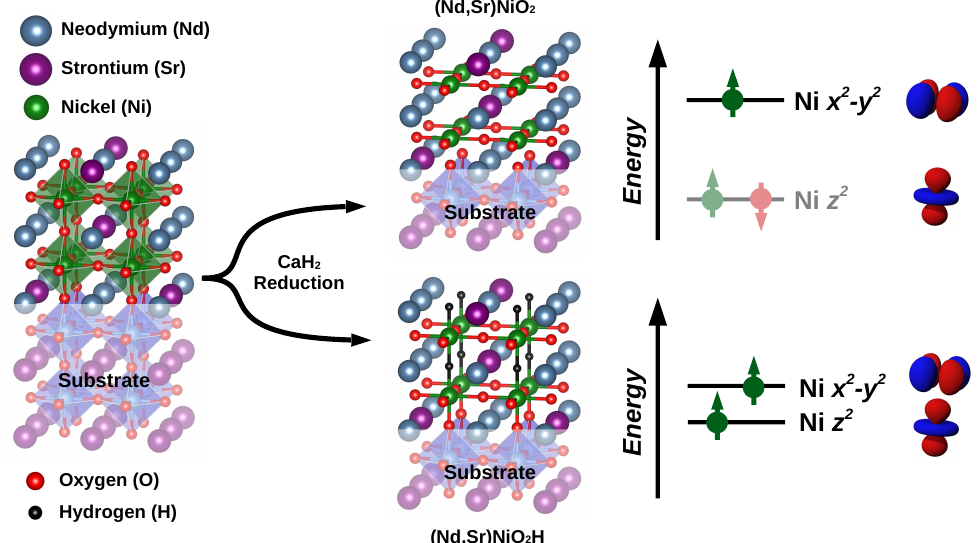
Figure 2. For synthesizing superconducting nickelates (1, left ), a perovskite film of Nd(La) 1 − x Sr x NiO 3 is grown on a SrTiO 3 substrate, and (2, center ) the O atoms between the planes are removed by reduction with CaH 2 . Besides the pursued nickelate Nd(La) 1 − x Sr x NiO 2 (top center), also excess oxygen or topotactic H may remain in the film, yielding Nd(La) 1 − x Sr x NiO 2 H ( bottom center ). The excess hydrogen results in two holes instead of one hole within the topmost two Ni 3 d orbitals ( right ). Adapted from Ref.